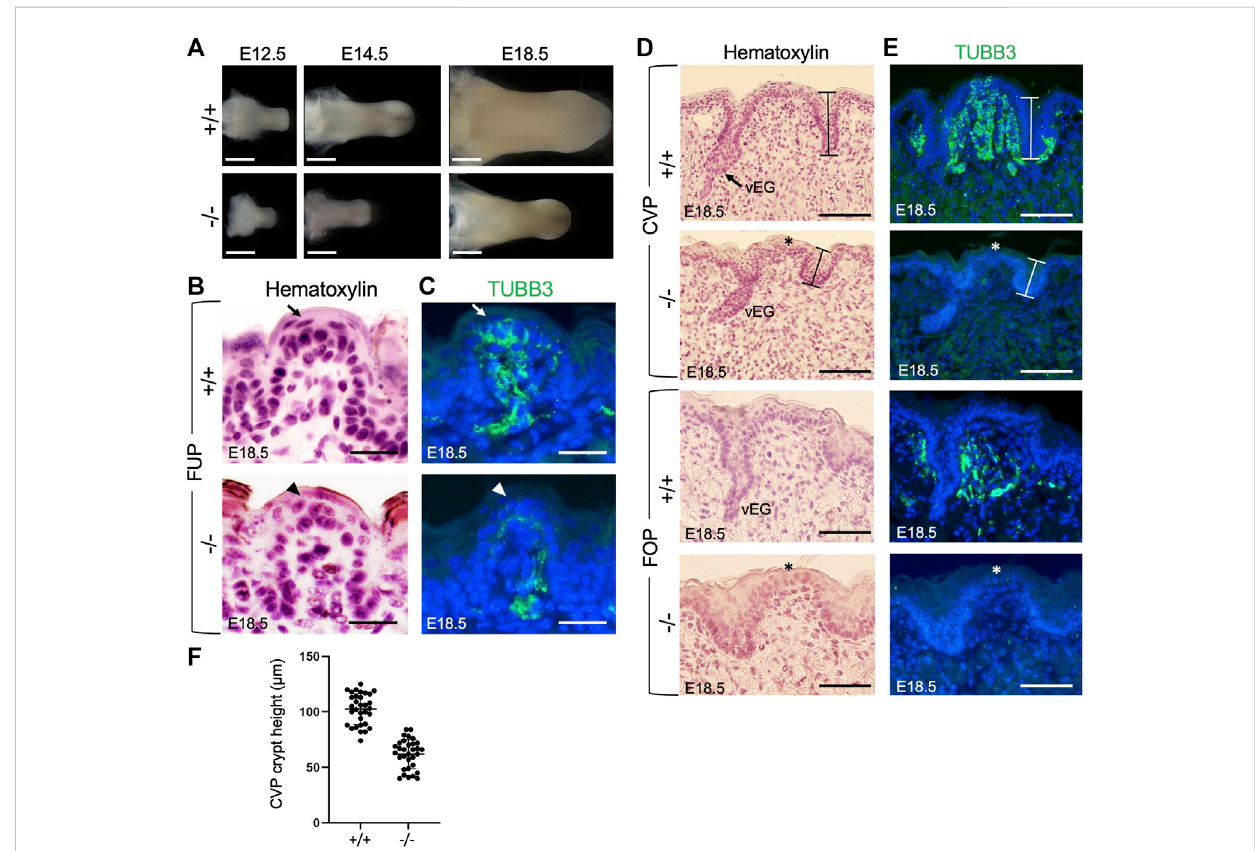
FIGURE 1 Eya1 de fi ciency leads to growth arrest of tongue and taste papillae during development. (A) Tongues of wild-type and Eya1 -null mice at E12.5, E14.5 and E18.5. (B, D) Hematoxylin-stained sections of E18.5 tongues showing FUP (B) and trenches of CVP and FOP with von Ebner ’ s glands (vEG) (D) in the wild-type and Eya1 − / − . (C, E) Immunostaining for anti-TUBB3 showing association of cranial gustatory nerves with papillae and trenches at E18.5, but reduced or lack of nerve contact in the mutant. Sections for FOP in D,E were sagittal, and all others were frontal. Arrows indicate well-developed taste buds with tightly clustered cells in wild-type FUP, and arrowheads indicate abnormal taste bud development in Eya1 − / − FUP. Asterisks indicate stunted CVP and FOP epithelium. (F) Statistical analysis showing the height of crypts across the entire CVP from three entire CVPs. Scale bars: 1 mm (A) , 200 μ m (lower magni fi cation in B), 50 μ m (higher magni fi cation in B), 30 μ m (FUP in C), 90 μ m (CVP in C) and 50 μ m (FOP in